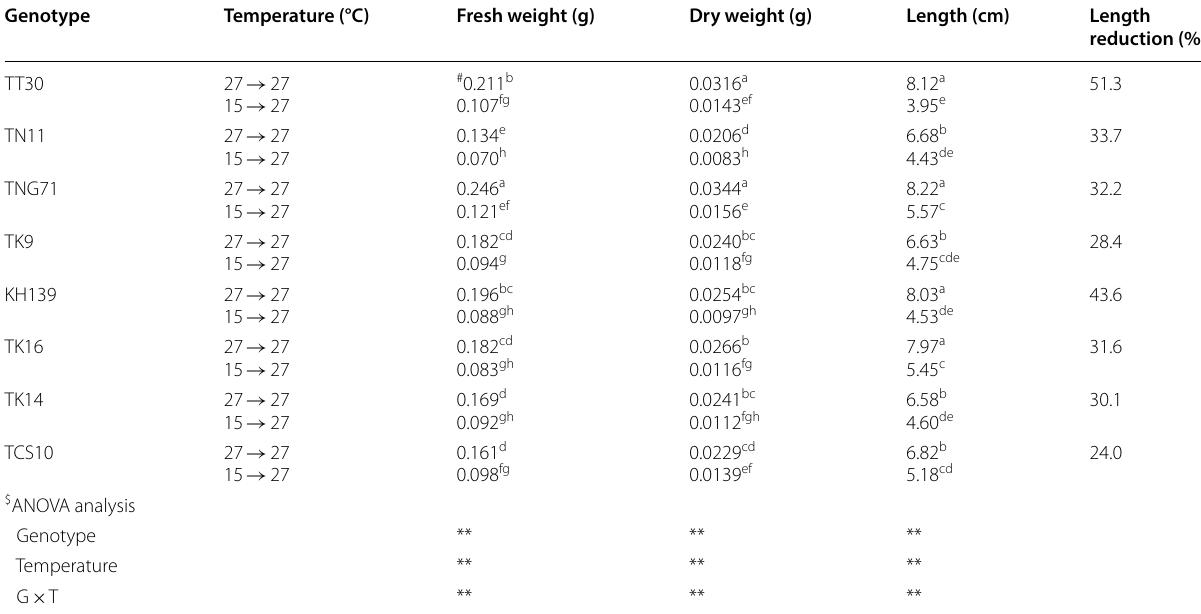
The temperature was set at 15 °C for cold treatment and 27 °C for control. After 4 days of treatment, the temperature was adjusted to 27 °C for 3 days before harvesting # Different letters represent the significant difference with LSD tests among cultivars or treatments (p < 0.05) $ G T: effect of genotype and temperature interaction; *p < 0.05; **p < 0.01 × Table 3 The cold stress response of rice seedlings